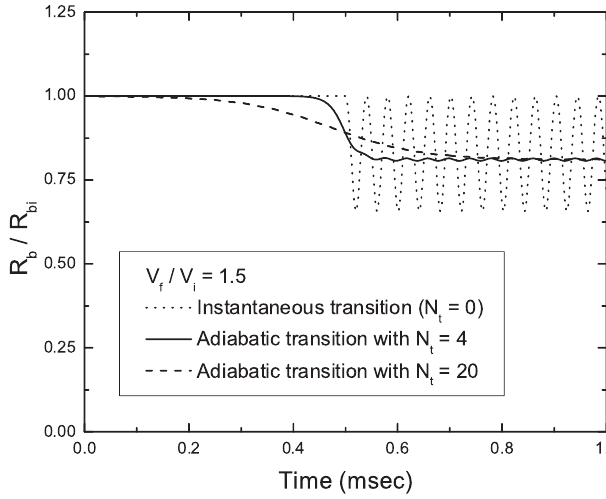
FIG. 5. Numerical solutions to the envelope Eq. (9) with (cid:2) (cid:5) t (cid:6) (cid:2) const . Evolution of the rms beam radius during an in- stantaneous transition (dotted line), adiabatic transition with (cid:2) 4 (solid line), and adiabatic transition with N (cid:2) 20 N t t (cid:2) 1 : 5 , (cid:5) sf =V is 49 : 8 (cid:3) , and f (cid:2) 60 kH z . (dashed line). Here, V f i vi